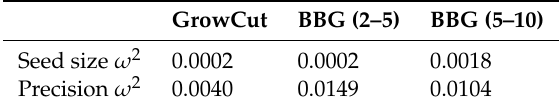
Table 2. ω 2 statistic (effect size) for the seed size and precision factors (MMWHS